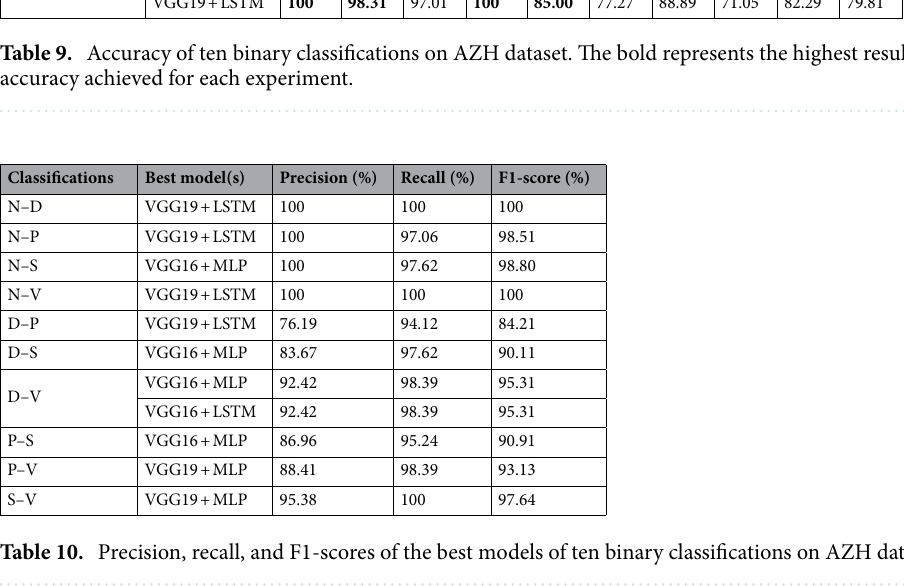
Table 9. Accuracy of ten binary classifications on AZH dataset. The bold represents the highest results/ accuracy achieved for each experiment.